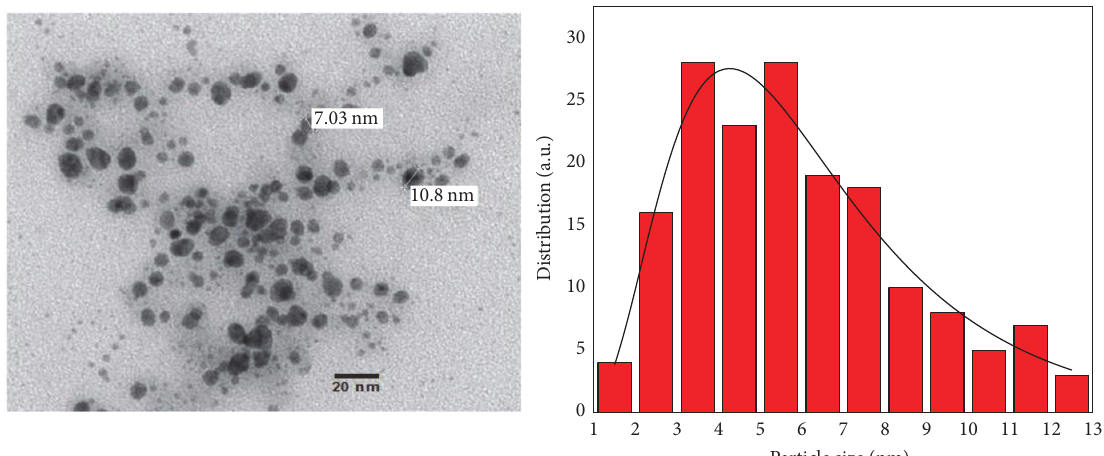
Figure 5: TEM image of copper nanoparticles sample and the particle size distribution histogram.